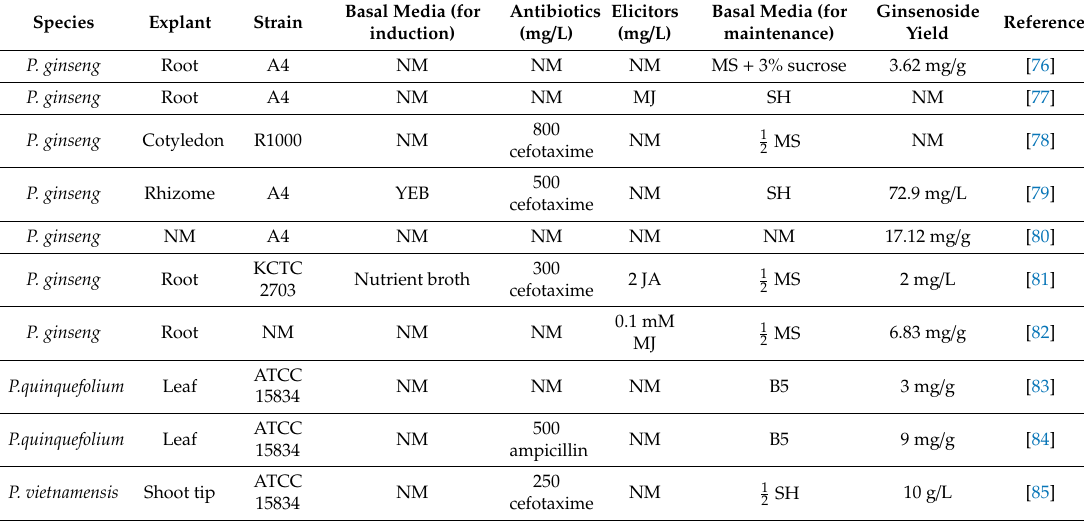
Table 4. Factors involved in and their influence on ginsenoside production during hairy root culture. Species Explant Strain